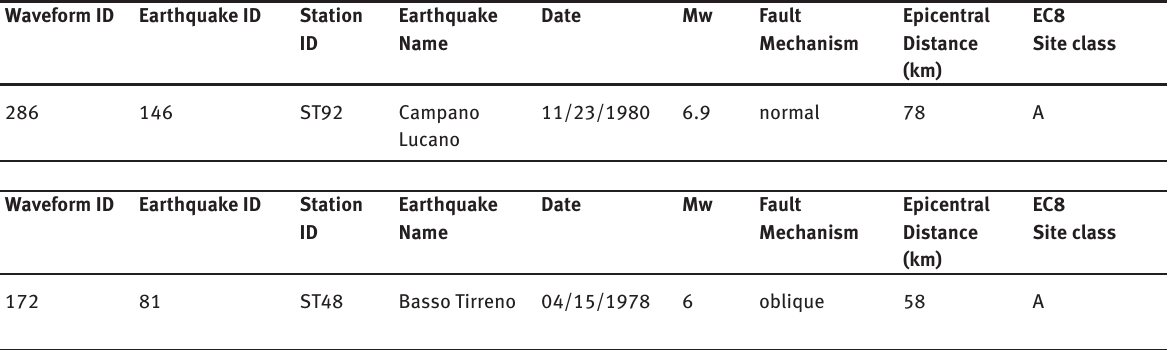
Table 4: Main data of the seismic events extracted from the database for the X-acceleration (above) and the Z-acceleration (below). Waveform ID Earthquake ID